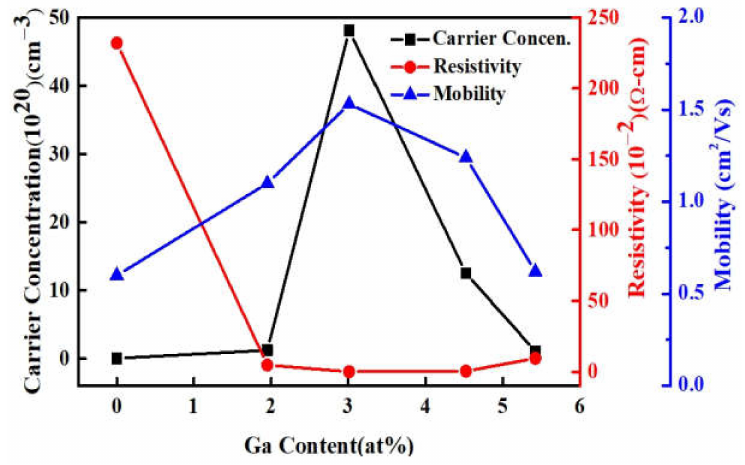
Figure 6. Hall measurements of ZnO and MIPEMOCVD-grown GZO thin films as a function of Ga content.